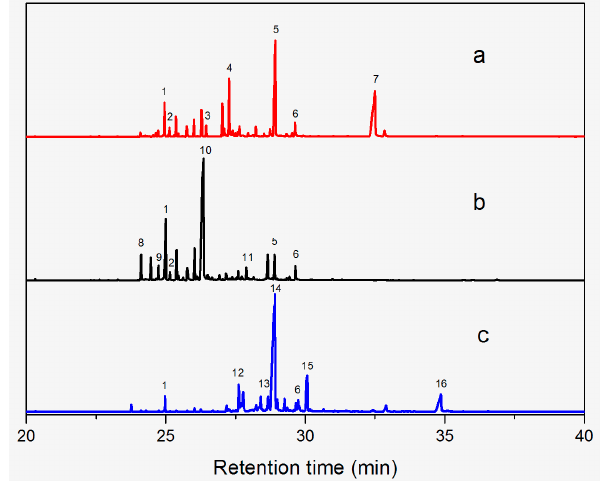
Figure 2. Total ion chromatogram: ( a ) D. cultrate , ( b ) D. latifolia , ( c ) D. melanoxylon .